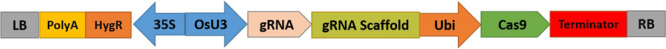
Schematic diagram of the construct used for genome editing. All three gRNAs were cloned in the same way. The construct was expressing gRNA under the OsU3 promoter. The rice codon-optimized Cas9 was expressing under the Ubi promoter.